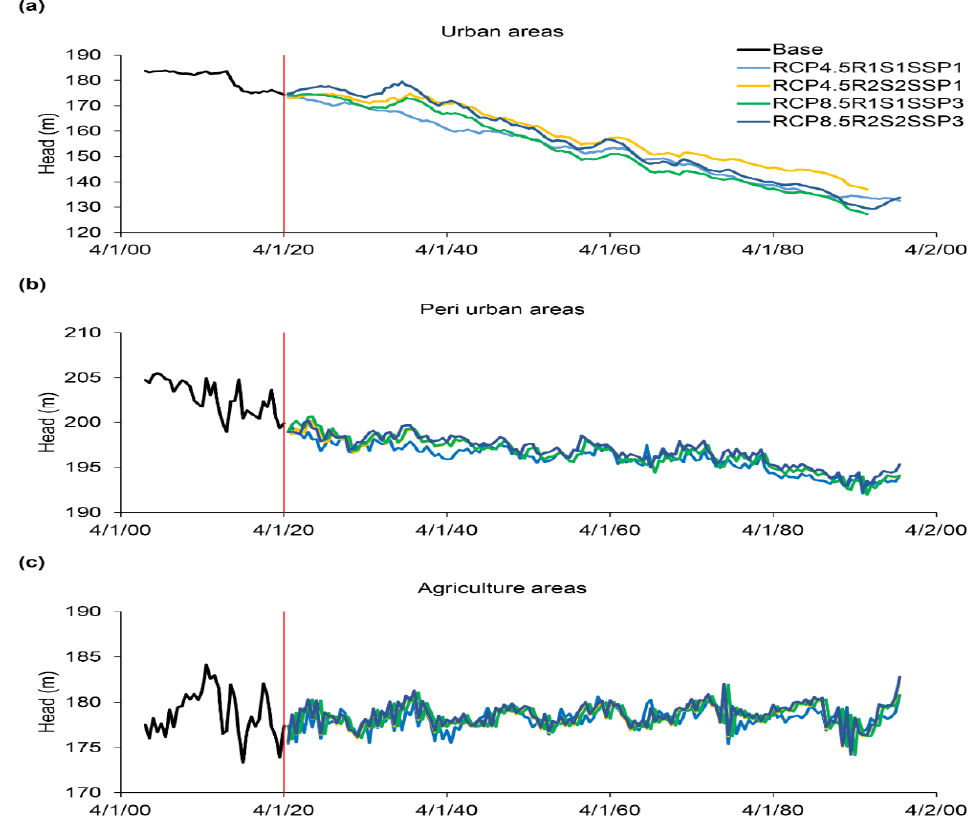
Figure 9. Projections of groundwater levels in Lahore division, for combined climate change, land-use change, and abstraction scenarios for the 21st century, ( a ) urban areas, ( b ) per urban areas, and ( c ) agricultural areas.